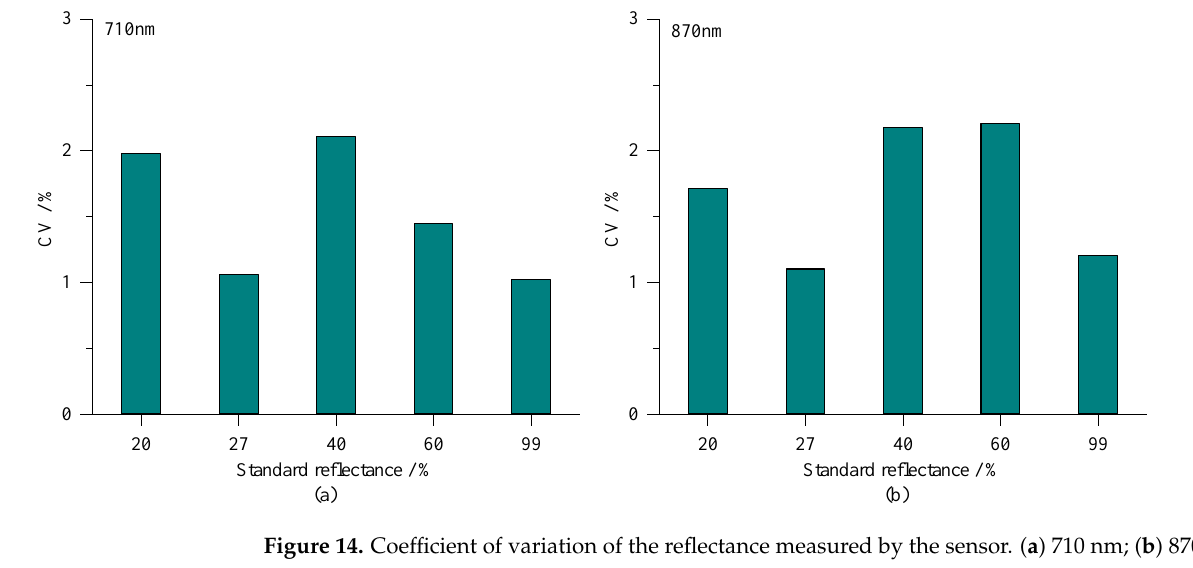
Figure 14. Coefficient of variation of the reflectance measured by the sensor. ( a ) 710 nm; ( b ) 870 nm.